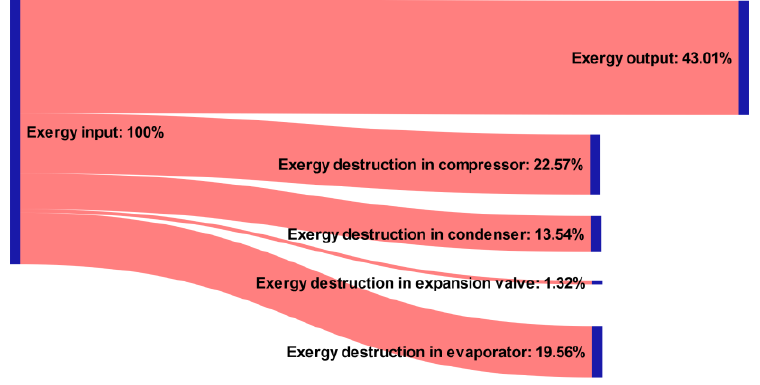
Fig. 9. Exergy destruction in two-stage compressor refrigeration